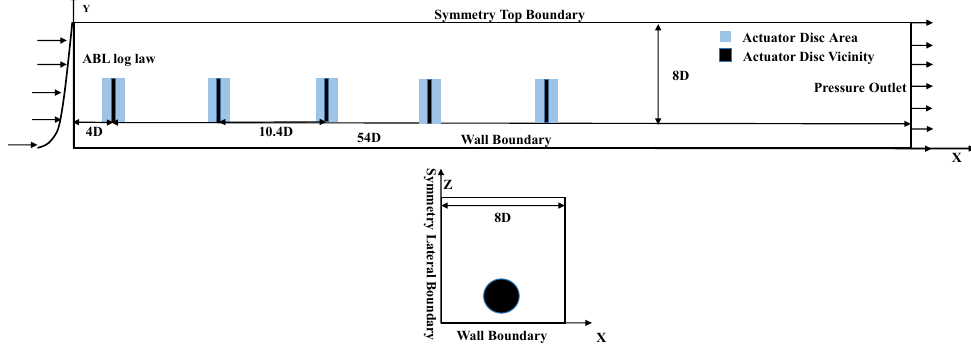
Figure 1. Computational domain and boundary conditions.